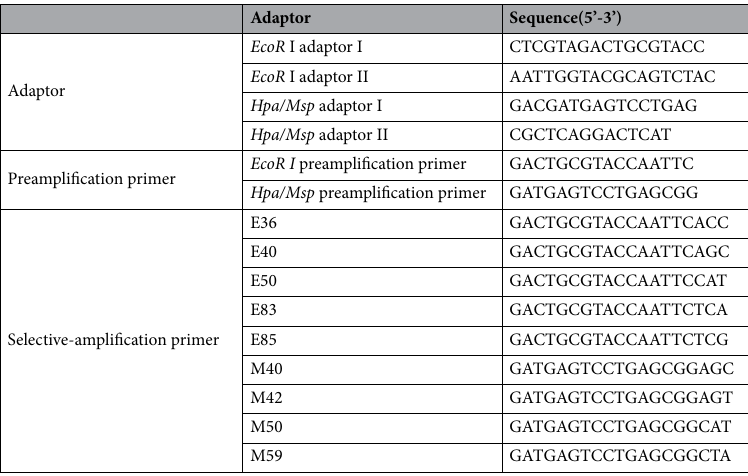
Table 7. Adaptors and primer sequences used for MSAP